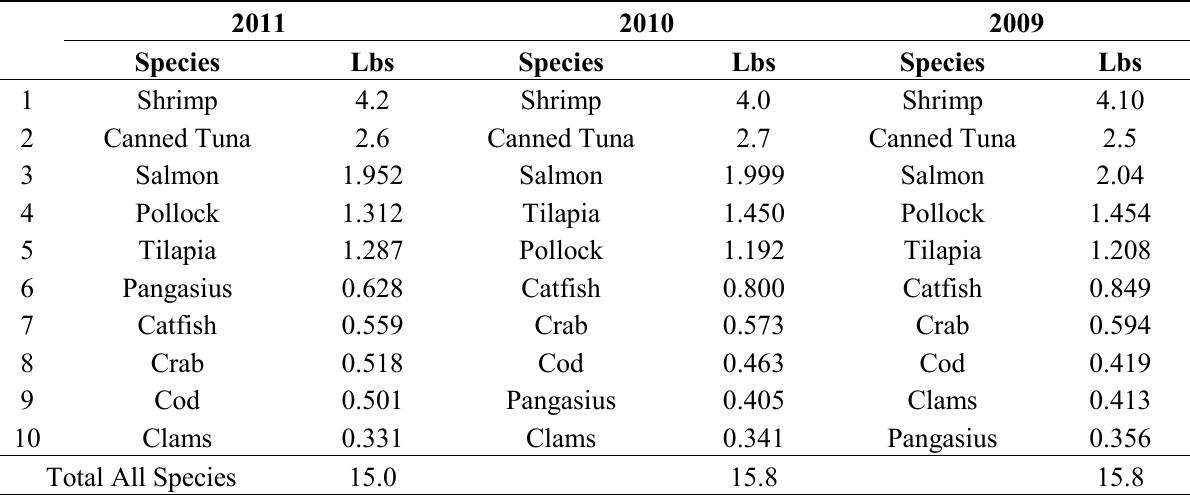
Table 3. US per capita fish consumption